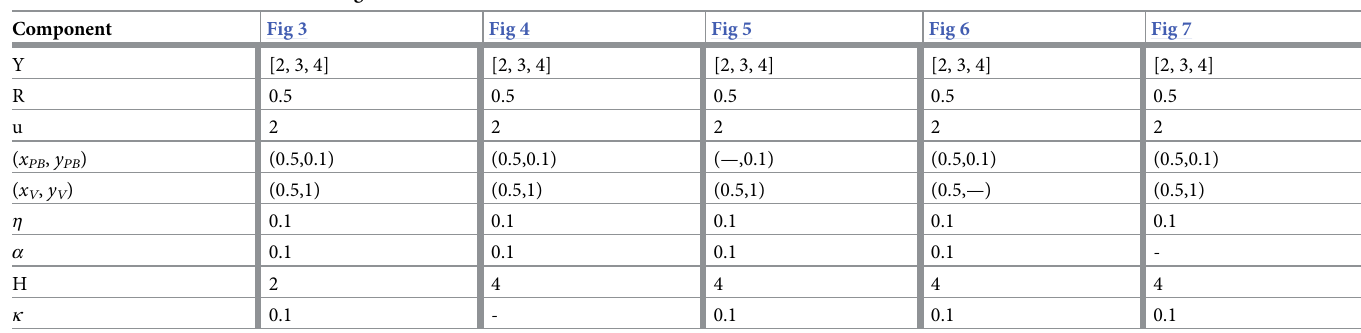
wireless network is adjusted by the components shown in Table 2. The OP numbers of MMPS, BPS, RPS, and SPS rose as κ grew, as can be seen in this graph. The MMPS still beat RPS, SPS, and BPS at all curve points. Furthermore, in high areas, the OP of all algorithms converged toward 1, specifically at κ � 0.55, which is consistent with the preceding section’s findings. The figure also illustrates that the MMPS algorithm is much more resistant to hardware failure than RPS, SPS, and BPS by 99.5%, 99.6%, 87.7% respectively, allowing it to function efficiently on devices with poor hardware quality. The probability of an outage is presented as a function of x in Fig 5 upon simulation by PB the components shown in Table 2. Apparently, when x grows to around 0.4, the outage PB